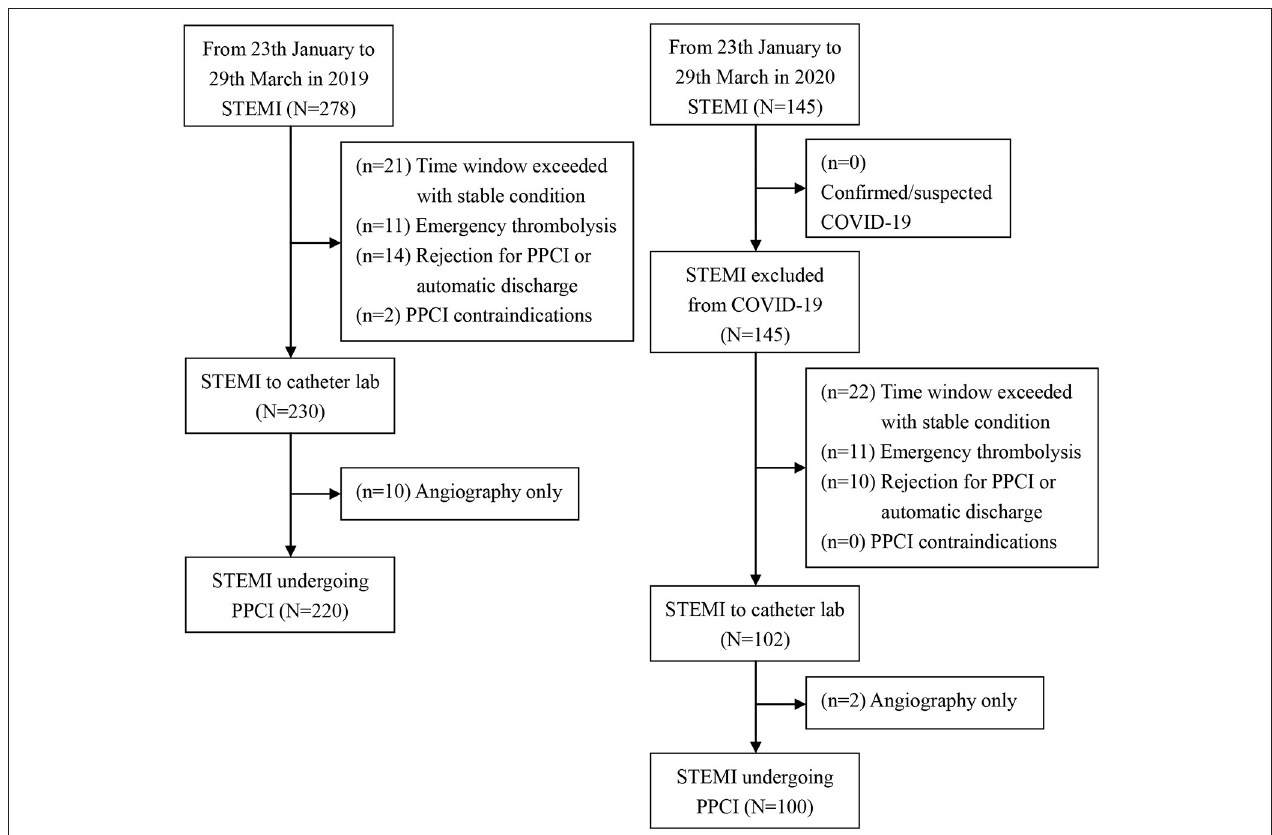
FIGURE 2 | Flowchart of study population.